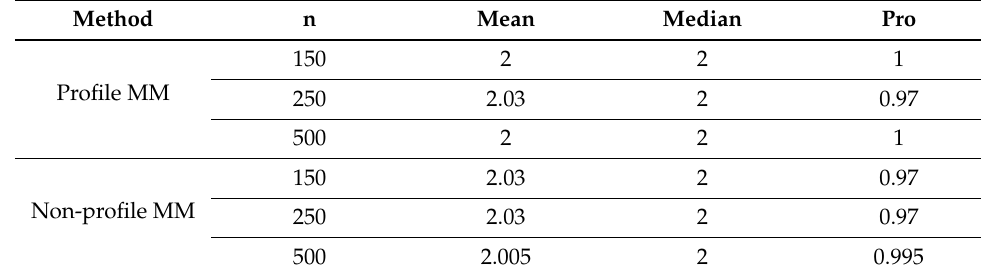
Table 1. The mean, median, standard error (s.d.), and the proportion (Pro) of ˆ M in Scenario 1.